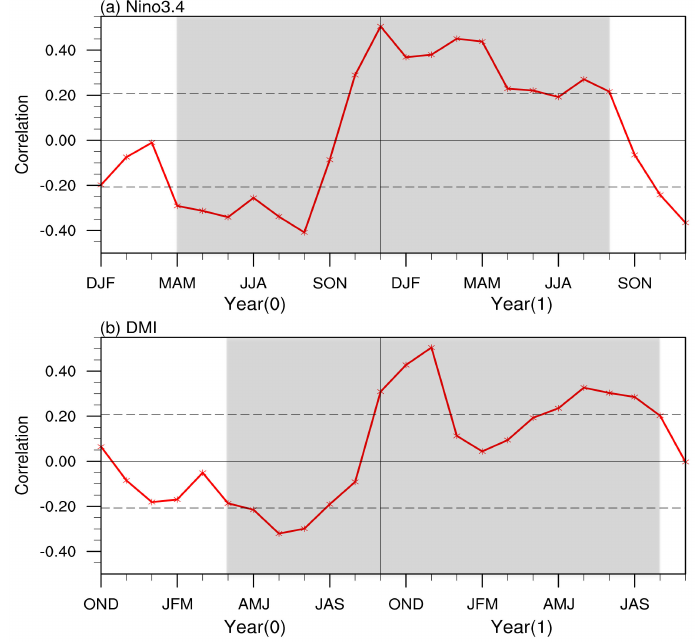
Figure 2. Lead–lag correlations between precipitation and ( a ) NDJ Nino3.4, and ( b ) SON DMI. Shown is the seasonally de-trended precipitation anomaly averaged over in China from 1950 to 2013. The horizontal dashed lines represent the 90% confidence level. The years which are post-fixed with (0) and (1) indicate the El Niño–Southern Oscillation (ENSO)- / Indian Ocean Dipole (IOD)-developing and subsequent years, respectively. Long light gray bars highlight the period from April(0) to